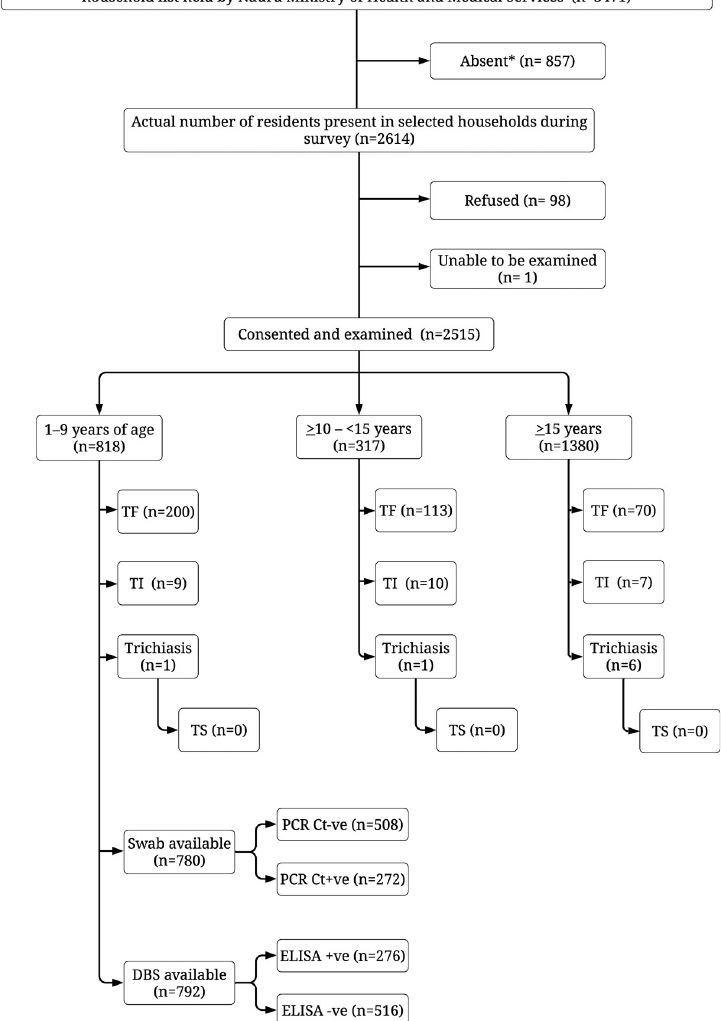
Fig 1. Recruitment and results flow diagram, Nauru, July 2019. Abbreviations: TF, trachomatous inflammation— follicular; TI, trachomatous inflammation—intense; TS, trachomatous scarring; PCR Ct, polymerase chain reaction Chlamydia trachomatis ; ELISA, enzyme-linked immunosorbent assay; +ve, positive; -ve, negative. � This is a slight underestimation due to inconsistent recording of absenteeism in the first week of the survey. During this first week, 16% (124/764) of people were recorded as absent vs 27% (733/2707) across the remaining 3 weeks of the survey. Extrapolating the average level of absenteeism over the last three weeks to the first week, we expect an additional 82 individuals were